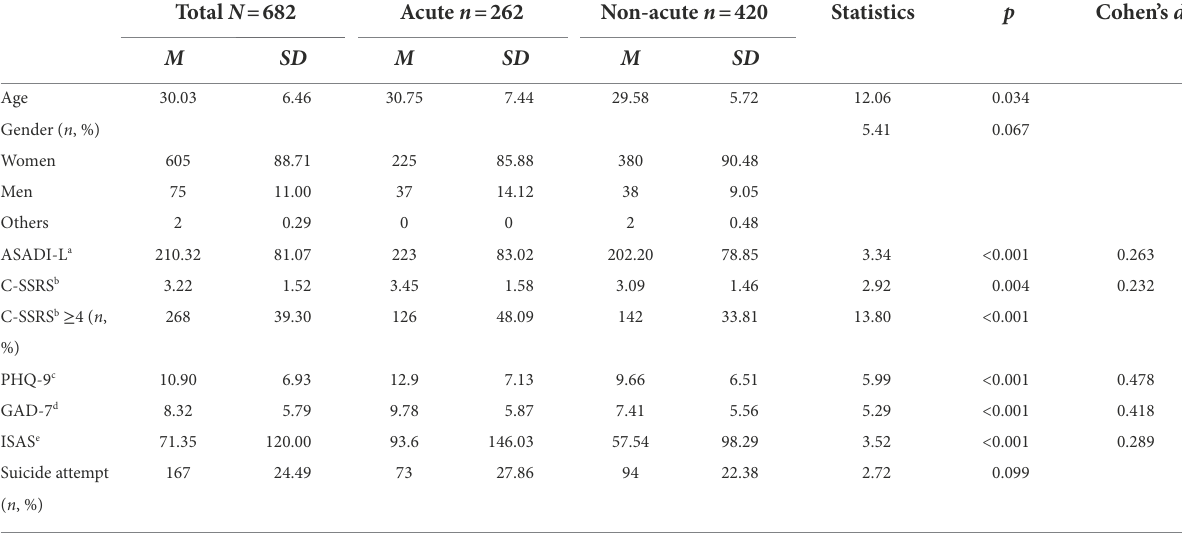
TABLE 2 Demographic and clinical characteristics of the acute and non-acute suicidal intention